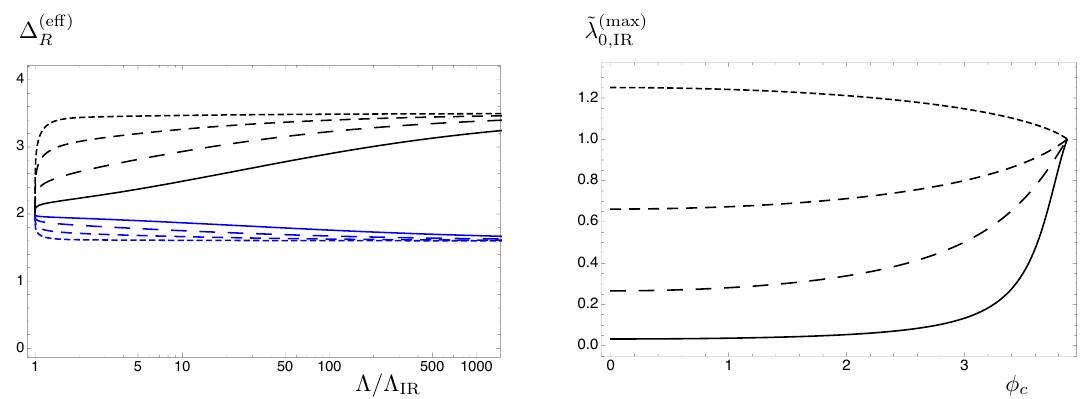
Figure 15 . Model II. Both panels have ∆ = 3 , x F = 1 , ∆ φ = 0 . 2 , and y 5 = 0 . The left panel shows the effective scaling dimension ∆ (eff) as a function of the energy scale Λ , for φ c = 1 , 2 . 5 , 3 . 3 , 3 . 7 R (short-dashed to solid lines), and two choices ∆ R = 1 . 6 , 3 . 5 (in blue, black). The right panel shows the maximum IR value ˜ λ (max) as a function of φ c , for Λ UV ’ 10 3 , and ∆ R = 1 . 7 , 2 . 3 , 2 . 6 , 3 0 , IR Λ IR (short-dashed to solid lines).